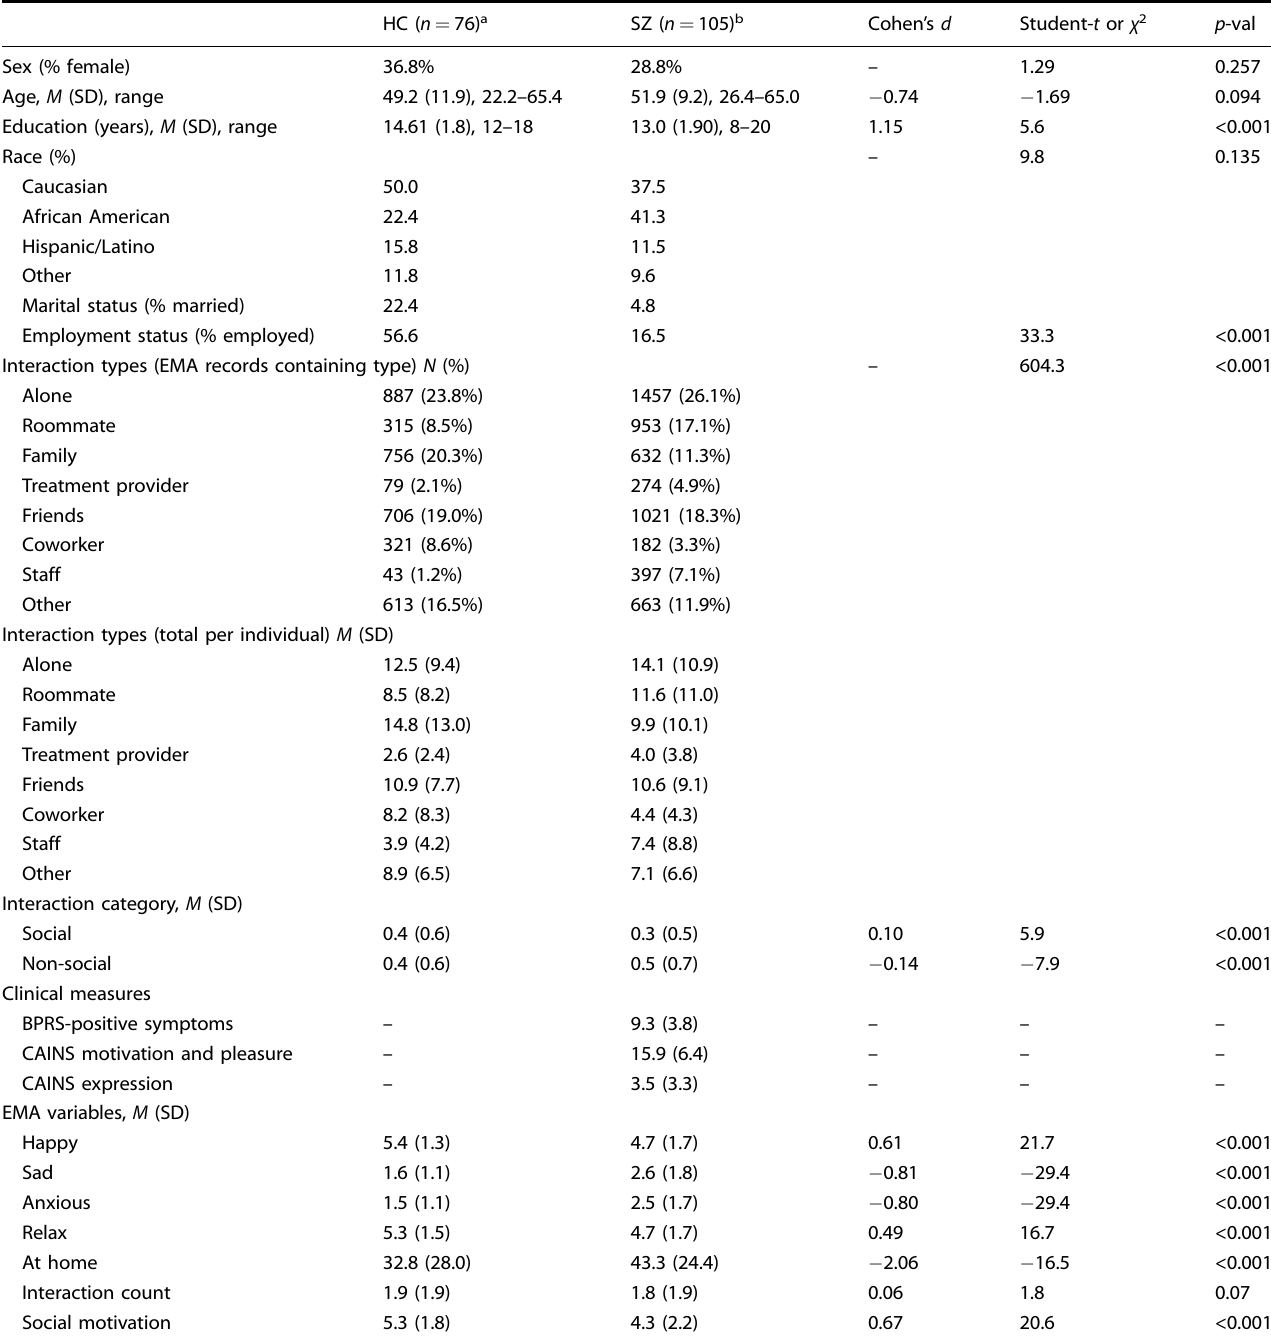
Table 1. Clinical characteristics of the study sample ( n =